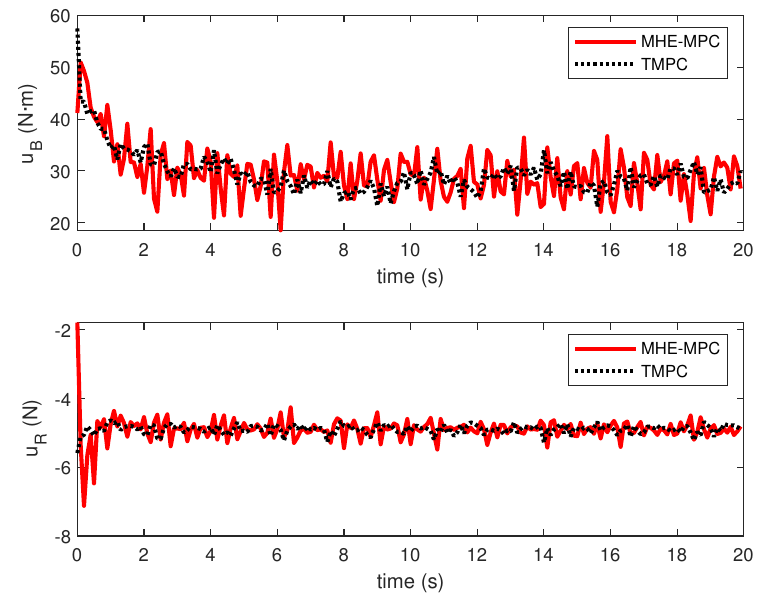
Figure 11. Case 2: control inputs u B and u R .